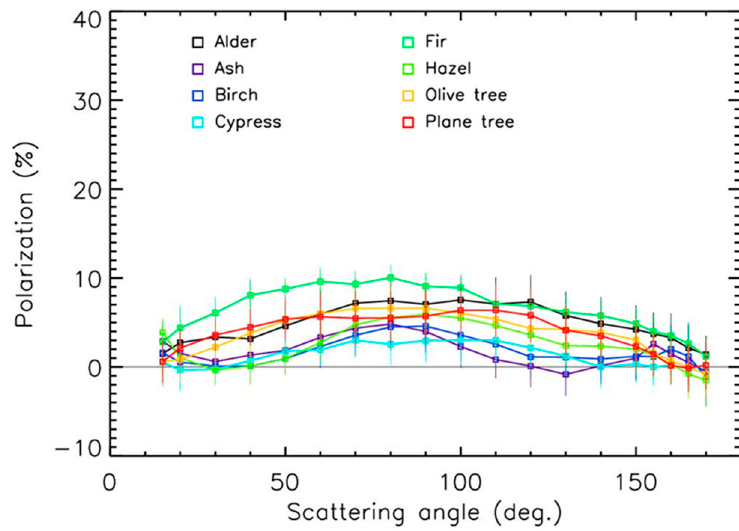
Figure 5. Polarization curves in the red domain for tree pollens.